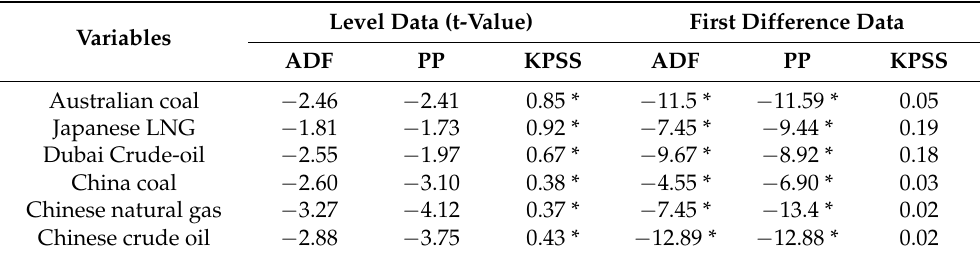
Table 1. Unit root